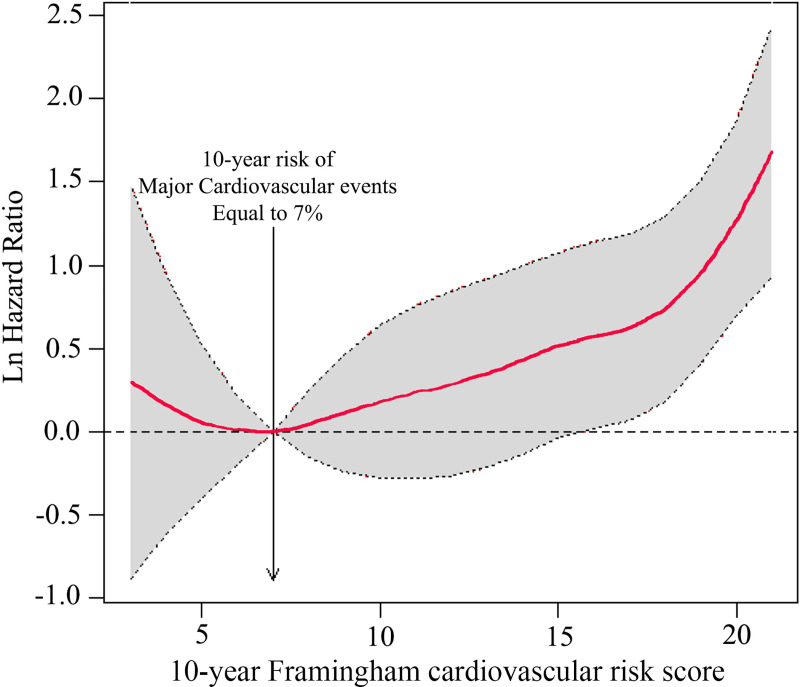
Natural cubic spline curve demonstrating a J-shaped relationship between efficacy of intensive blood pressure reduction and 10-year Framingham cardiovascular risk.